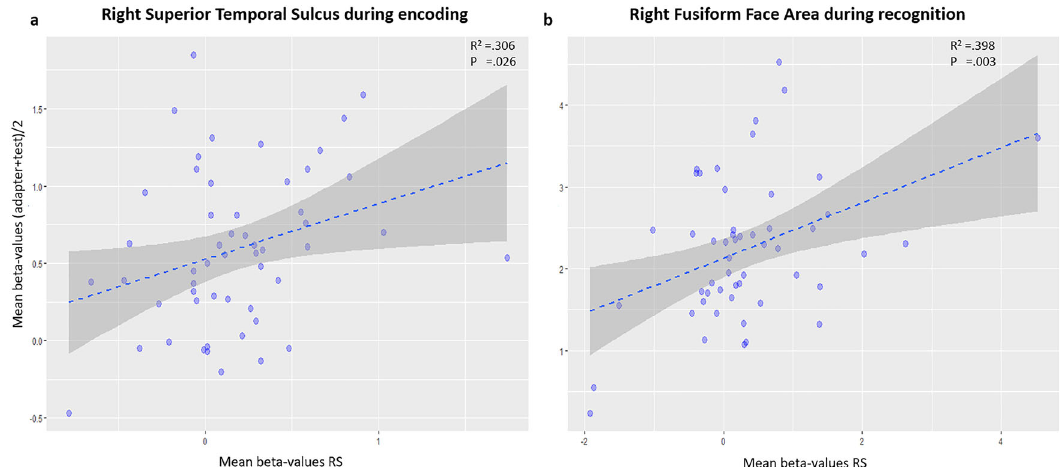
Fig. 4 Scatterplot for the face-selective area. a Two-sided Pearson ’ s correlation using Oldham ’ s method revealed a positive correlation ( p = 0.026) between activation for initial response and RS in the right pSTS during encoding. b Two-sided Pearson ’ s Correlation using Oldham ’ s method revealed a positive correlation ( p = 0.003) between activation during the initial response (immediate recognition; IR) and RS in the right FFA during recognition. N = 54.